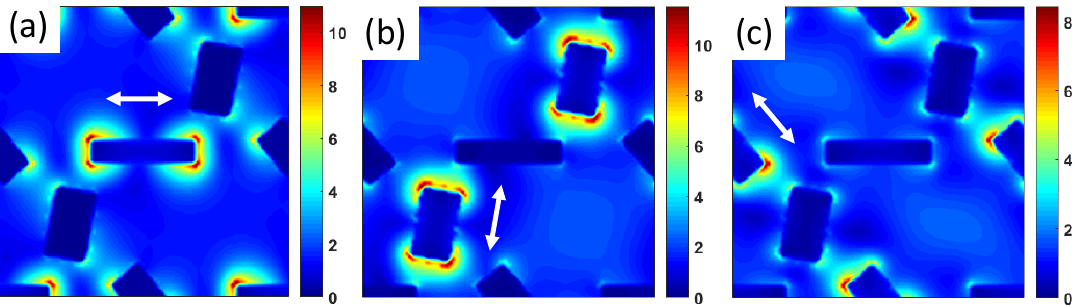
Figure 3. Calculated electric field distribution at the middle of the rods at ( a ) 620 nm, ( b ) 540 nm and ( c ) 450 nm. White arrows denote polarization angle of